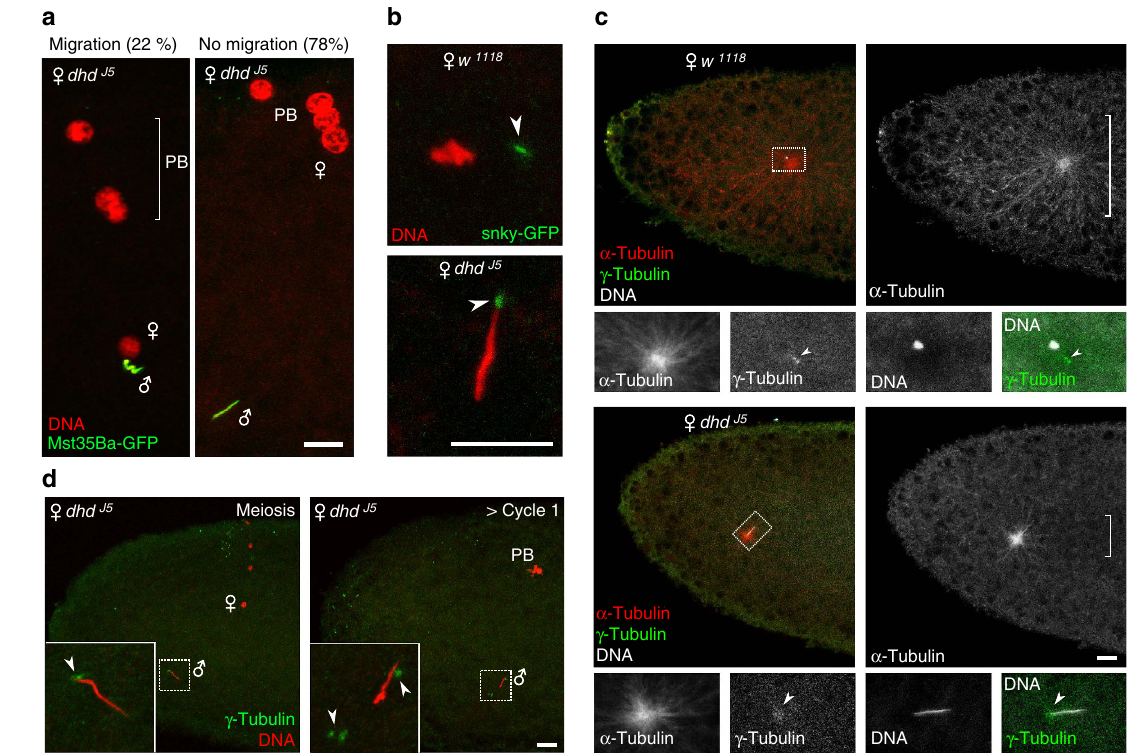
Figure 2 | Sperm aster formation and pronuclear migration are affected in dhd eggs. ( a ) Left: a dhd egg at pronuclear apposition. The three polar bodies (PB) are visible. Right: a dhd egg in which the female pronucleus failed to migrate and remained associated with the polar bodies. The respective percentage of each phenotype is indicated ( n ¼ 586). Sperm nuclei were visualized using the paternal Mst35Ba-GFP transgene (green). DNA is stained with propidium iodide (red). ( b ) Top panel: a w 1118 egg during meiosis II showing the male nucleus and the sperm acrosome (arrowhead). Bottom: a dhd eggs during meiosis II with the acrosome still associated to the anterior extremity of the sperm nucleus (arrowhead). The acrosome is visualized with the paternal Snky-GFP marker. ( c ) Eggs in telophase of meiosis II from w 1118 and dhd J5 females stained for DNA (white), a -tubulin (red) and g -tubulin (green) to reveal nuclei, the sperm aster and the centrosomes, respectively (the female meiotic products are not visible on these confocal sections). In w 1118 eggs (upper panels), the anti- g -tubulin stains the zygotic centrosome (which contains a pair of sperm centrioles) at proximity of the male pronucleus (100%, n ¼ 25; arrowhead, inset). In dhd eggs (lower panels), the centrosome appears diffused and almost systematically associated (98%, n ¼ 53) to the compacted sperm nucleus (arrowhead, inset). The brackets indicate the extent of the sperm aster in w 1118 and dhd J5 eggs. ( d ) Left: a dhd egg in telophase of meiosis II. Right: a dhd embryo after the end of cycle 1. The centrosomes (arrowheads, inset) have duplicated and detached from the male nucleus. The rosette of polar body (PB) chromosomes is visible. Green: g -tubulin, red: DNA. Scale bars, 10 m